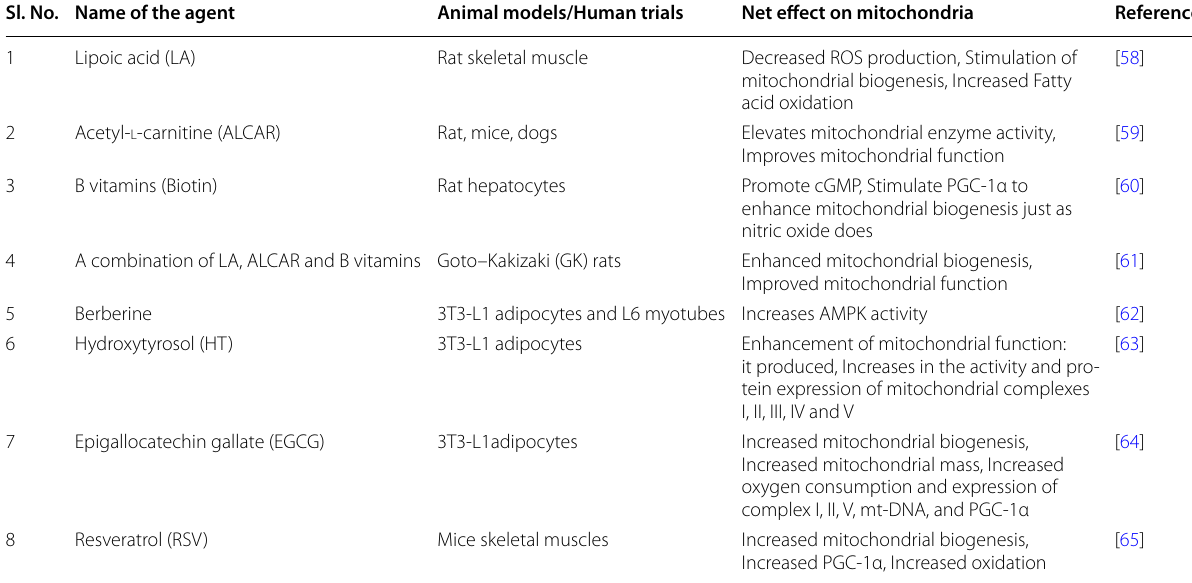
Table 1 Natural components that improve mitochondrial dysfunction and/or their biogenesis Sl. No. Name of the